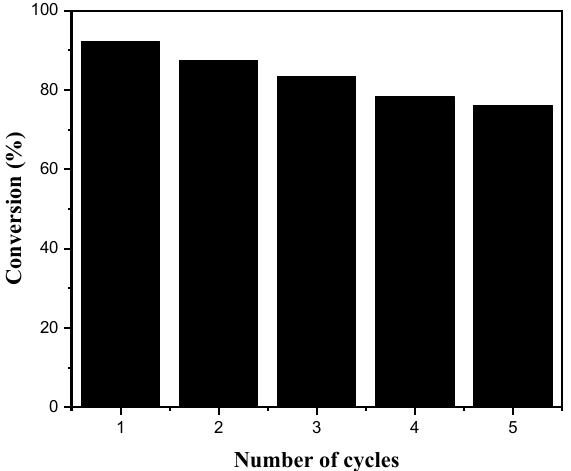
Figure 8. Recycling test results of the Cs 2 H 4 PV 3 MoW 8 O 40 catalyst for the transesterification of soybean oil. Reaction conditions: methanol / oil molar ratio, 30:1; catalyst amount, 3 wt.%, reaction time, 8 h; reaction temperature, 140 °C.